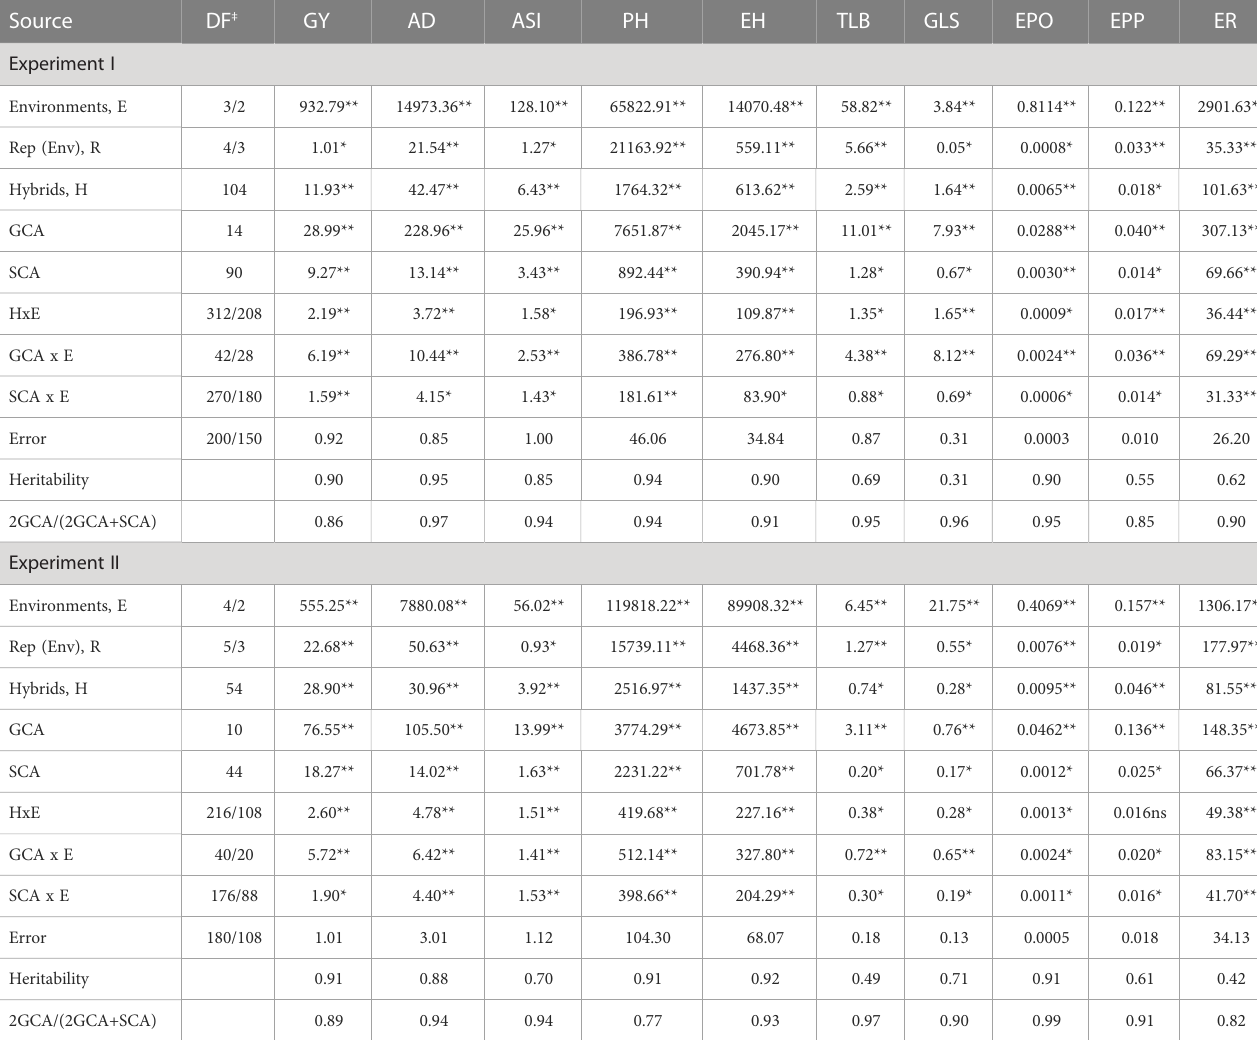
TABLE 5 Mean squares for grain yield and other agronomic traits of 160 medium maturing tropical maize hybrids evaluated in two diallel experiments under optimal conditions in three to fi ve locations in Kenya.